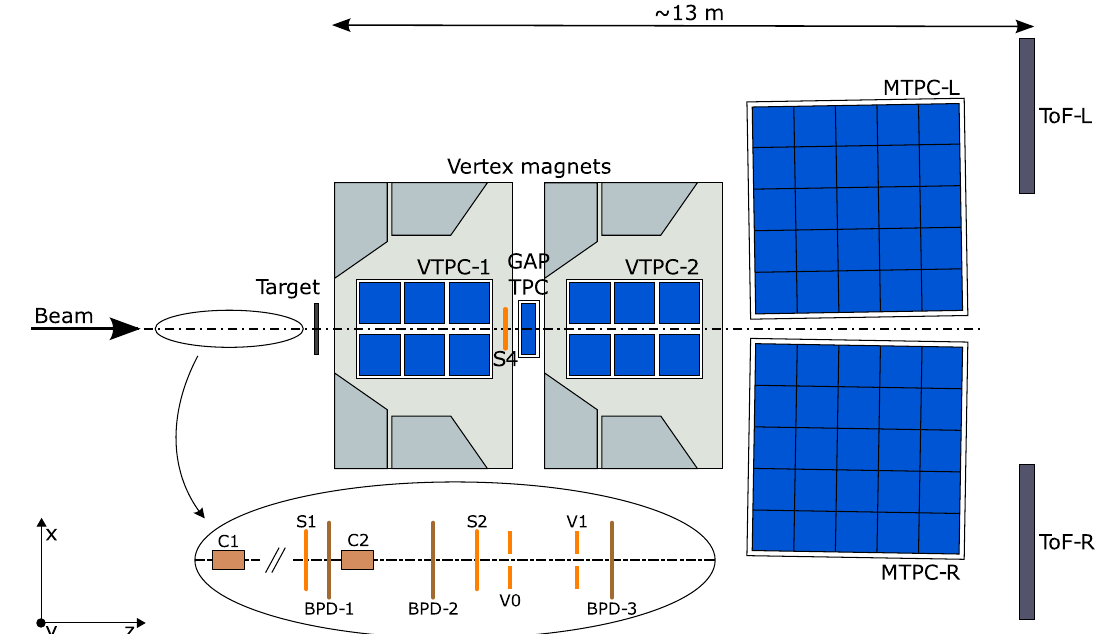
Fig. 1 Schematic layout of the NA61/SHINE experiment at the CERN SPS (horizontal cut, not to scale) showing the detectors used in the data taking. The orientation of the NA61/SHINEcoordinate system is